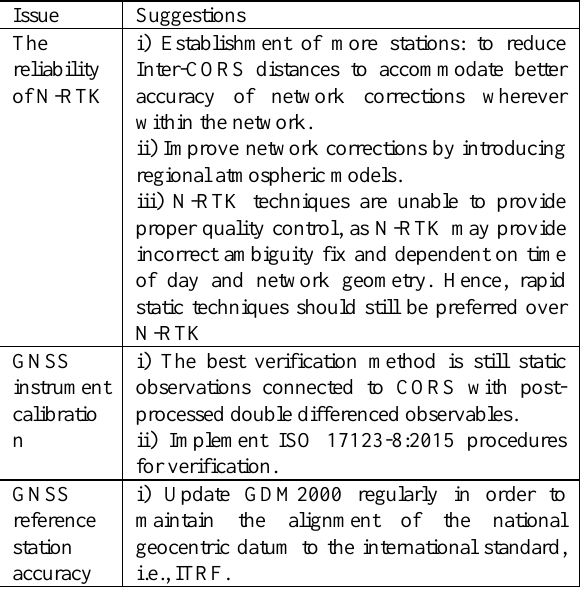
Table 2: Additional GNSS Applications Guideline in